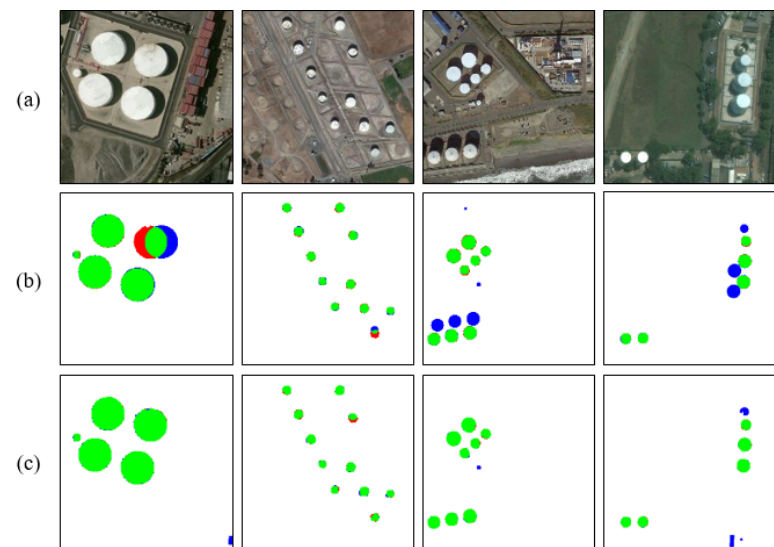
Figure 12. Comparison of two detection methods when shadow interference occurs. ( a ) is the input image, ( b ) is the method from Ok, ( c ) is our method.